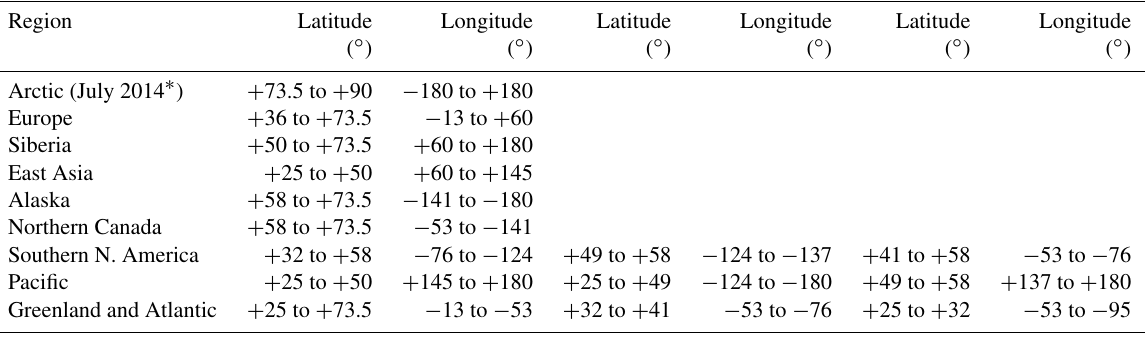
Table 2. Geographical extent of chosen source regions